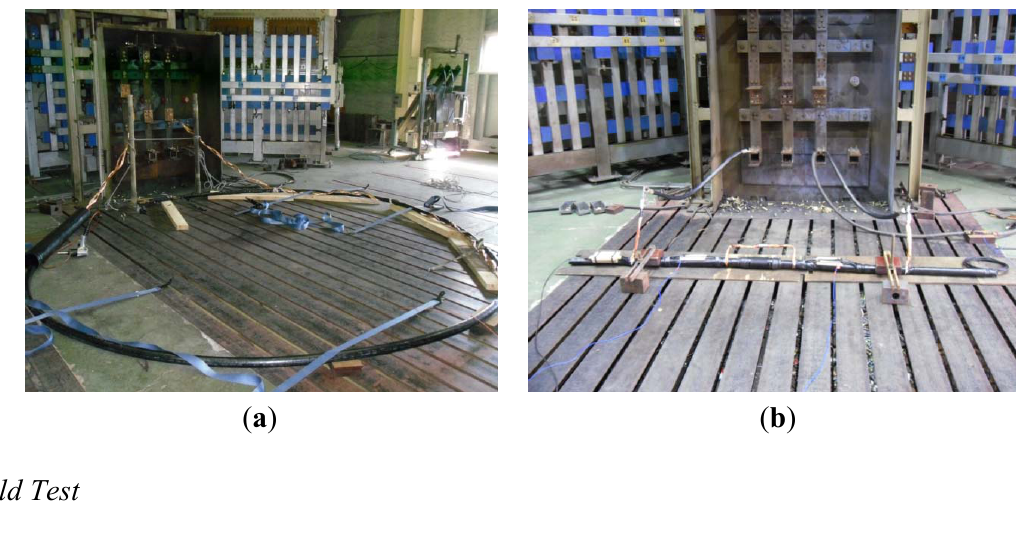
Figure 9. Short-circuit test: ( a ) OFCPC and ( b ) cable